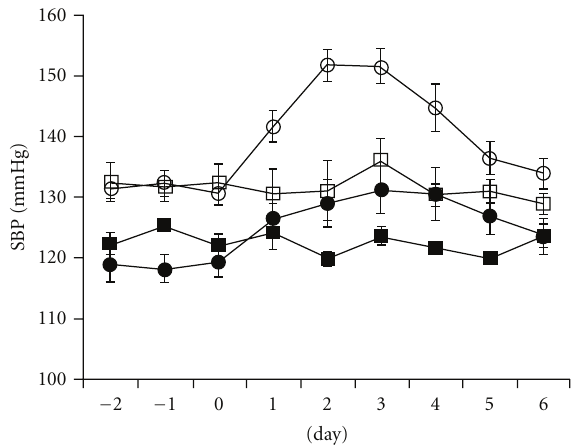
Figure 2: E ff ects of chronic AngII infusion on SBP . Daily changes of SBP in saline infusion [APA − / − ( (cid:2) ) and APA + / + ( (cid:3) )] and AngII infusion [APA − / − ( ◦ ) and APA + / + ( • )] mice. The implantation of osmotic minipupms was done on day 0. Values are mean ±